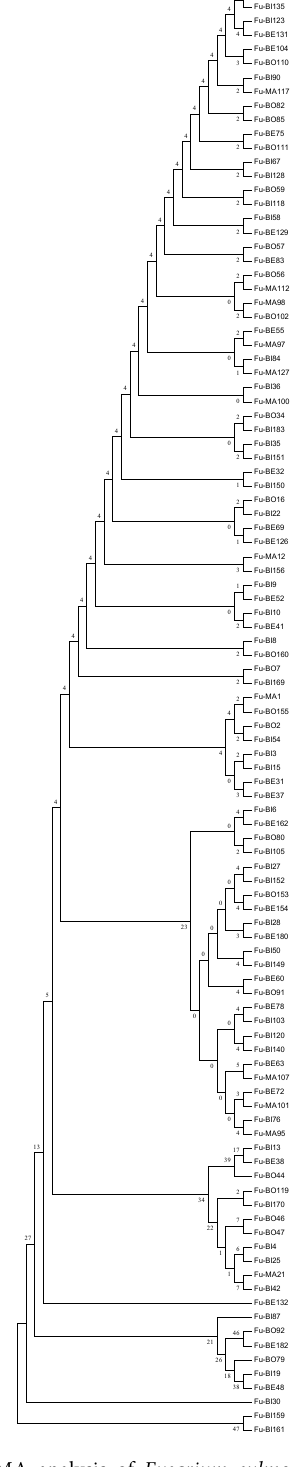
Figure 2 UPGMA analysis of Fusarium culmorum populations, based on combined ISSR data analyzed using using pairwise dis- tances matrix. The numbers on the branches represent bootstrap support